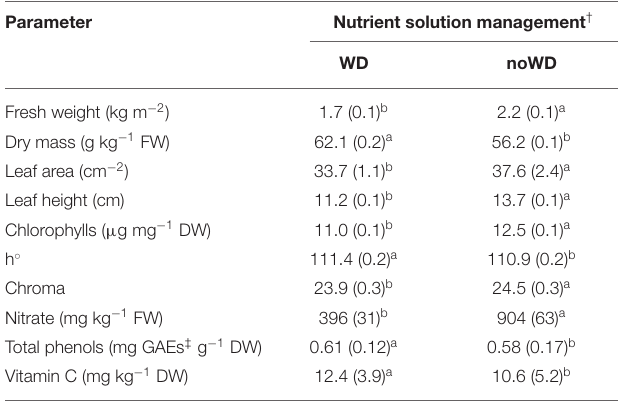
TABLE 7 | Effect of nutrient solution management before harvest on yield, bio-morpho-physiological traits, nitrate, chloride and antioxidant compound concentrations of C. endivia leaves. The standard error of mean is in